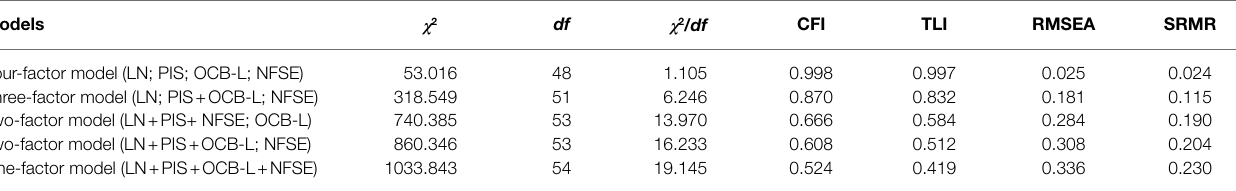
TABLE 1 | Confirmatory factor analyses.